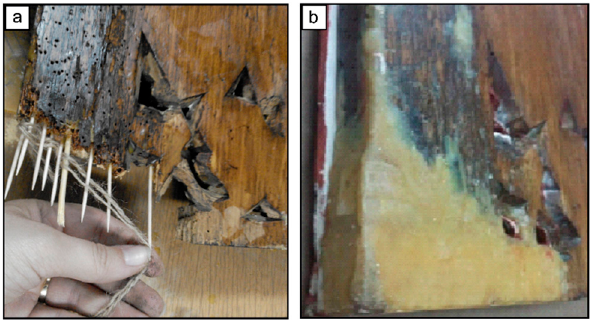
Figure 7. Installation of the reinforcement made from bamboo sticks and flax oakum ( a ) in the filling area by sawdust grout ( b ).